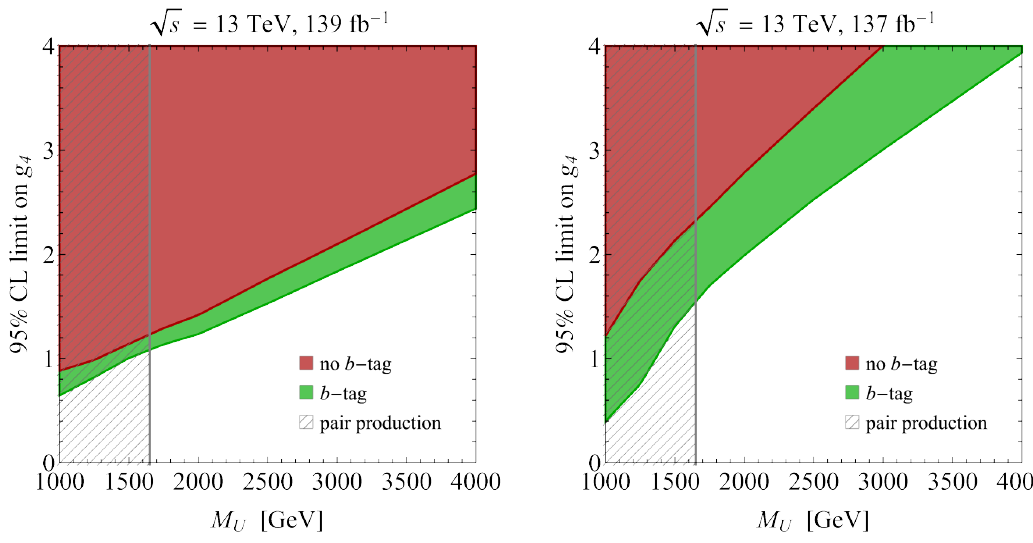
Figure 8 . As figure 7 but using a recast of the results of the ATLAS [51] and CMS [55] ditau search in the left and right panel, respectively. For additional details see the